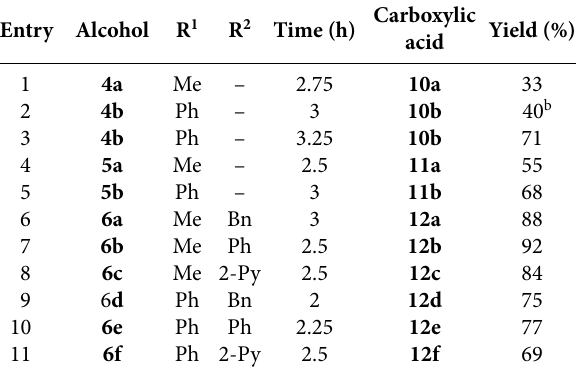
Table 4. Oxidation of primary alcohols 4a,b , 5a,b , and 6a–f to car- boxylic acids 10a,b , 11a,b , and 12a–f , respectively a .